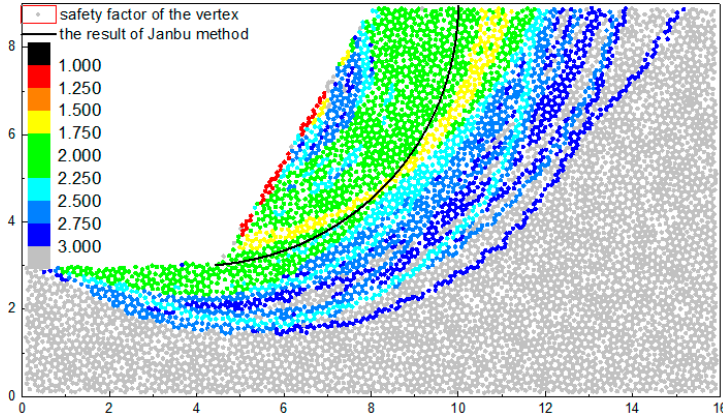
Figure 14. The safety factors of the slope example calculated by the characterization method of the contact surface.